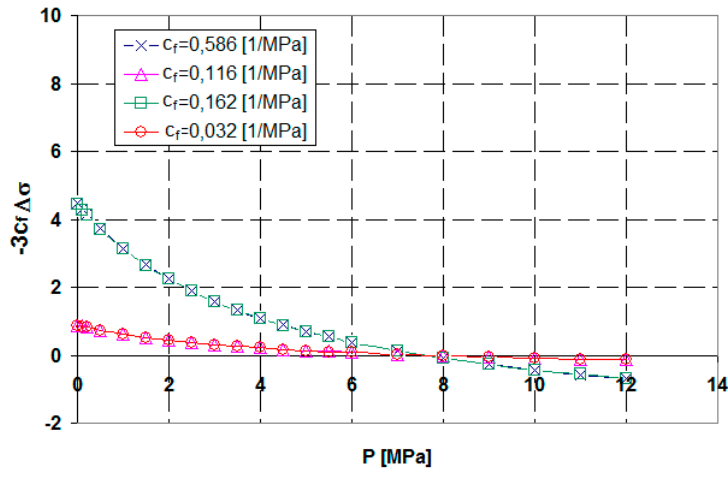
Figure 5. Deformations caused solely by desorption based on the Cui and Bustin model. 254